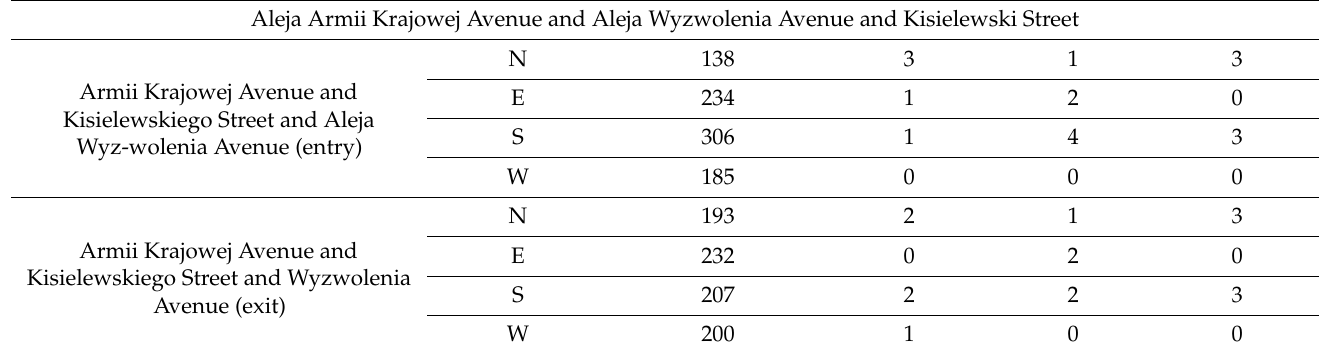
lane for driving straight ahead, southern direction: green light: 85 s, red light: 23 s, • turn lane western direction: red light: 67 s, green light: 42